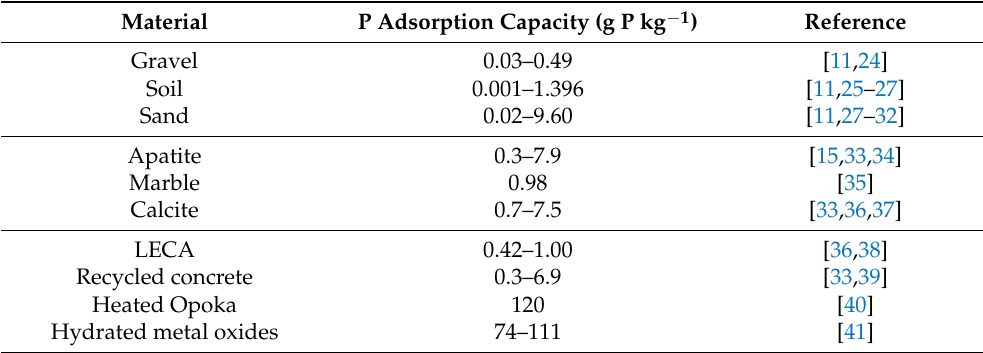
Table 7. Reported P adsorption capacities in literature.